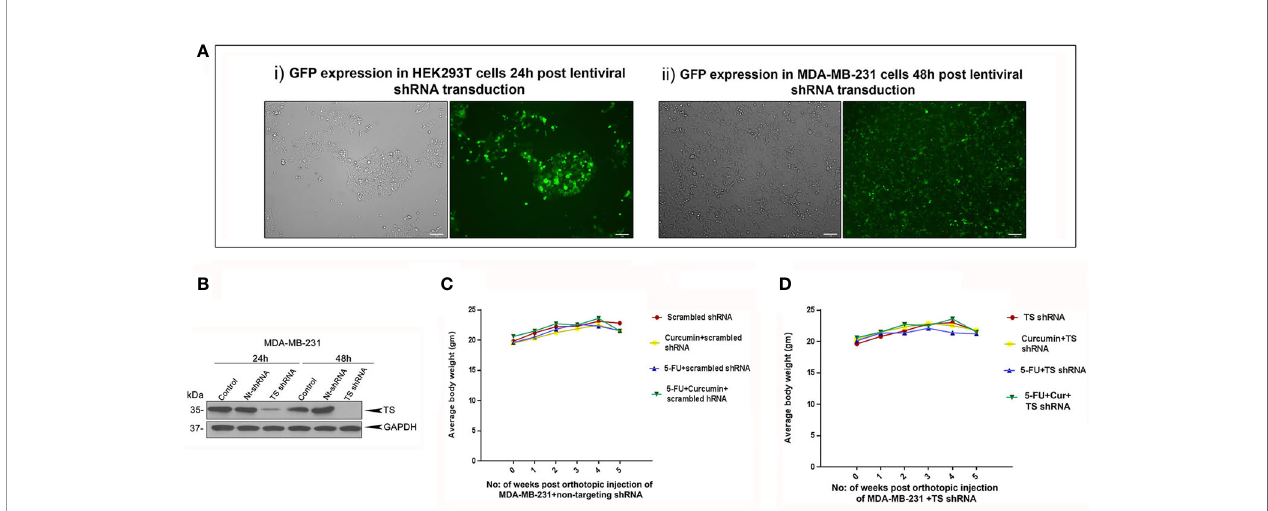
FIGURE 4 | Analysis of the ef fi ciency of lentiviral transduction and expression status of TS in transduced cells. (A) Ef fi ciency of lentiviral transfection in HEK 293T cells and successive infection in MDA-MB-231 cells, respectively as assessed by GFP expression. (B) Time-dependent analysis of expression status of TS in MDA-MB-231 cells transduced with TS shRNA compared to that of untreated control and cells transduced with control/non-targeting shRNA (Nt-shRNA) using immunoblotting. GAPDH levels are shown as the loading control. (C, D) Comparison of body weight from different treatment groups bearing MDA-MB-231 TS xenografts and MDA-MB-231 TS- xenografts,